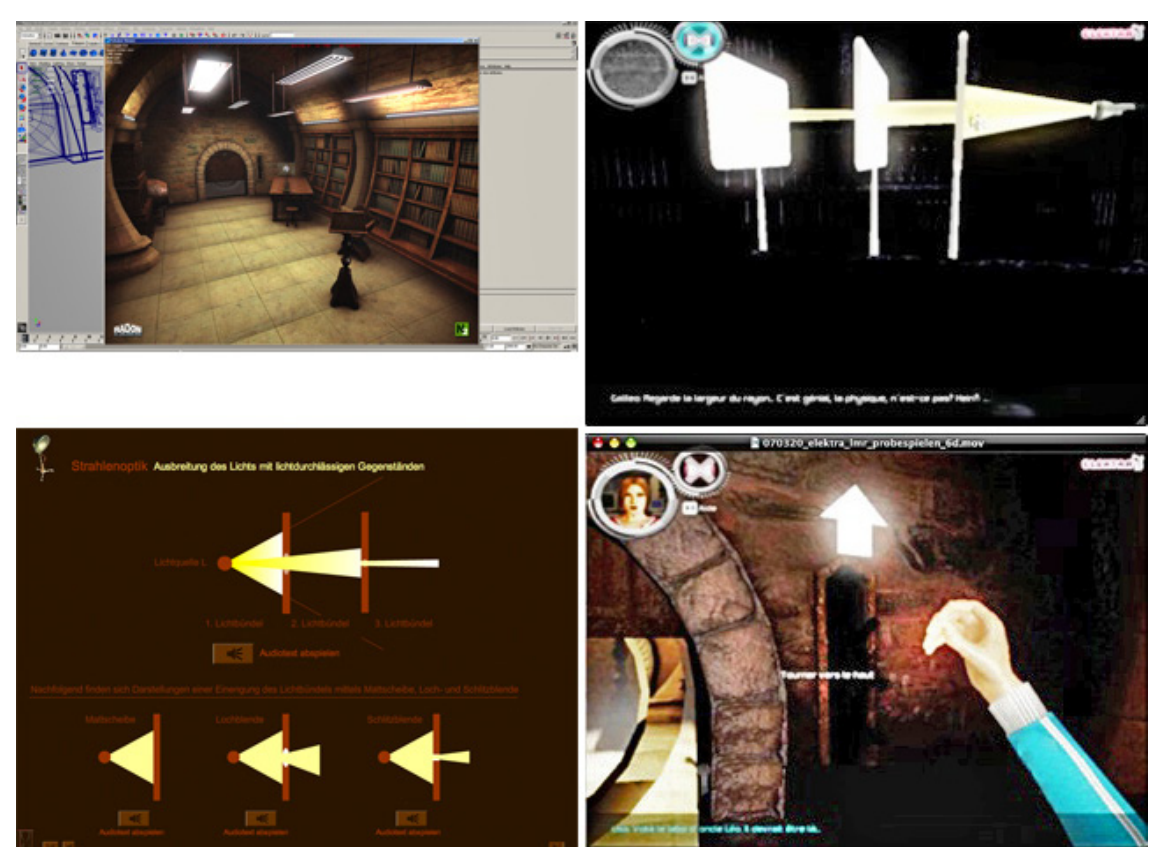
Figure 2. Design of Elektra with extrinsic support in the form of a hyperlinked textbook. In contrast, the third design condition (G_IS), featuring intrinsic support, provides dynam- ically embedded support whenever necessary. The system offers support via a pedagogical agent that gives simple hints to encourage learners to keep trying if they have made an error. If a learner repeatedly fails to solve a given learning task, the system provides com- ments and explanations that contain the correct answer (see Figure